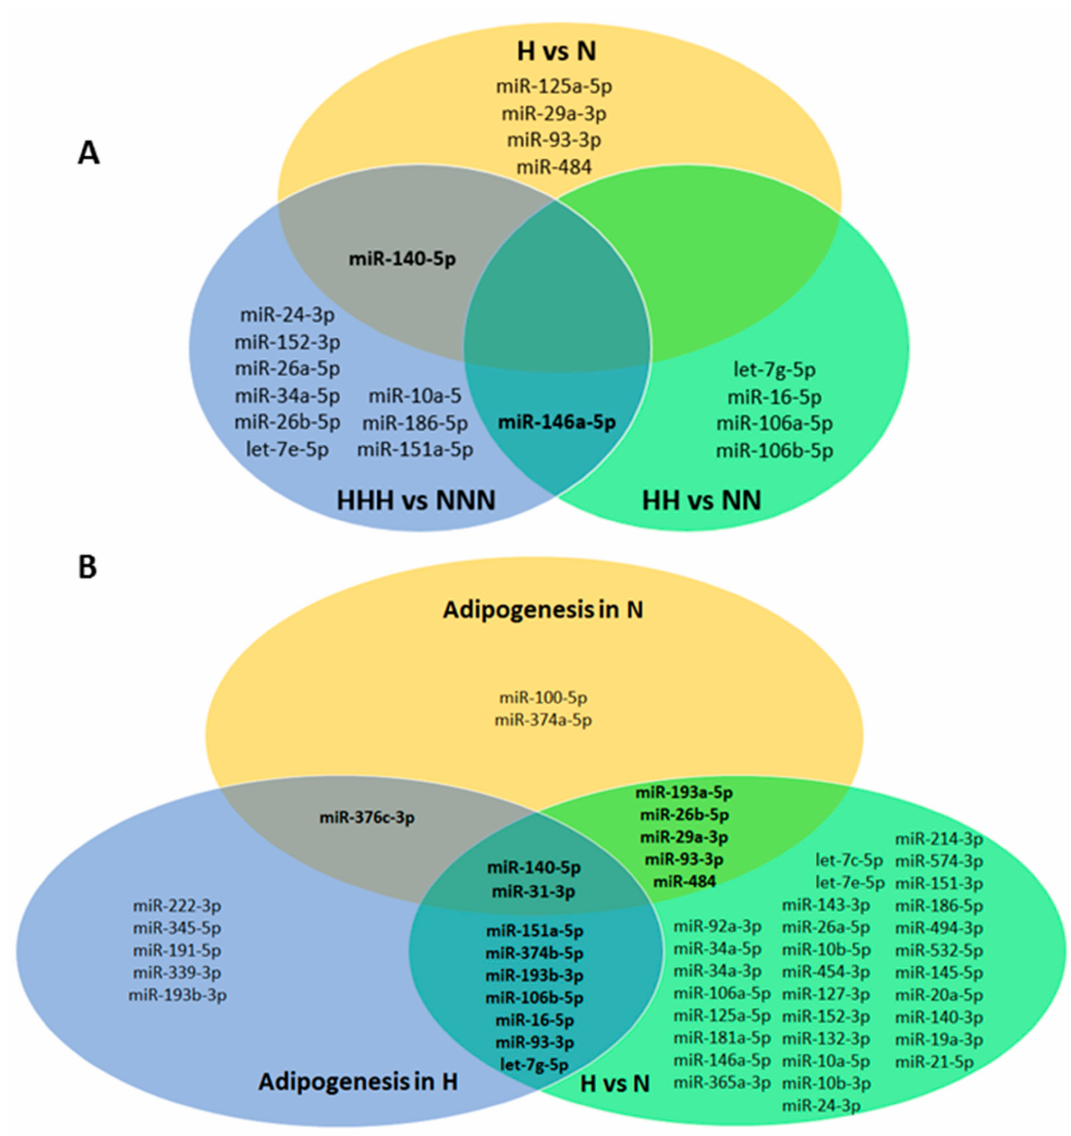
Figure 5. miRNAs significantly changed upon HG and ADG. ( A ) Venn diagram shows significantly changed miRNAs upon chronic HG. ( B ) Venn diagram presents significantly changed miRNAs during ADG in NG and HG as well as upon chronic or intermittent HG. Shared miRNAs are bolded. Statistical significance was evaluated using two-tailed t-test with p ≤ 0.05 considered as